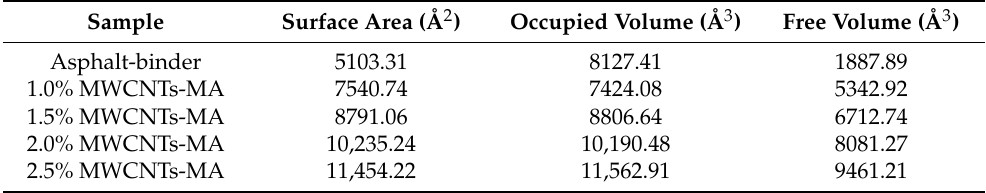
Table 4. Effects of MWCNTs content on molecular aggregation.